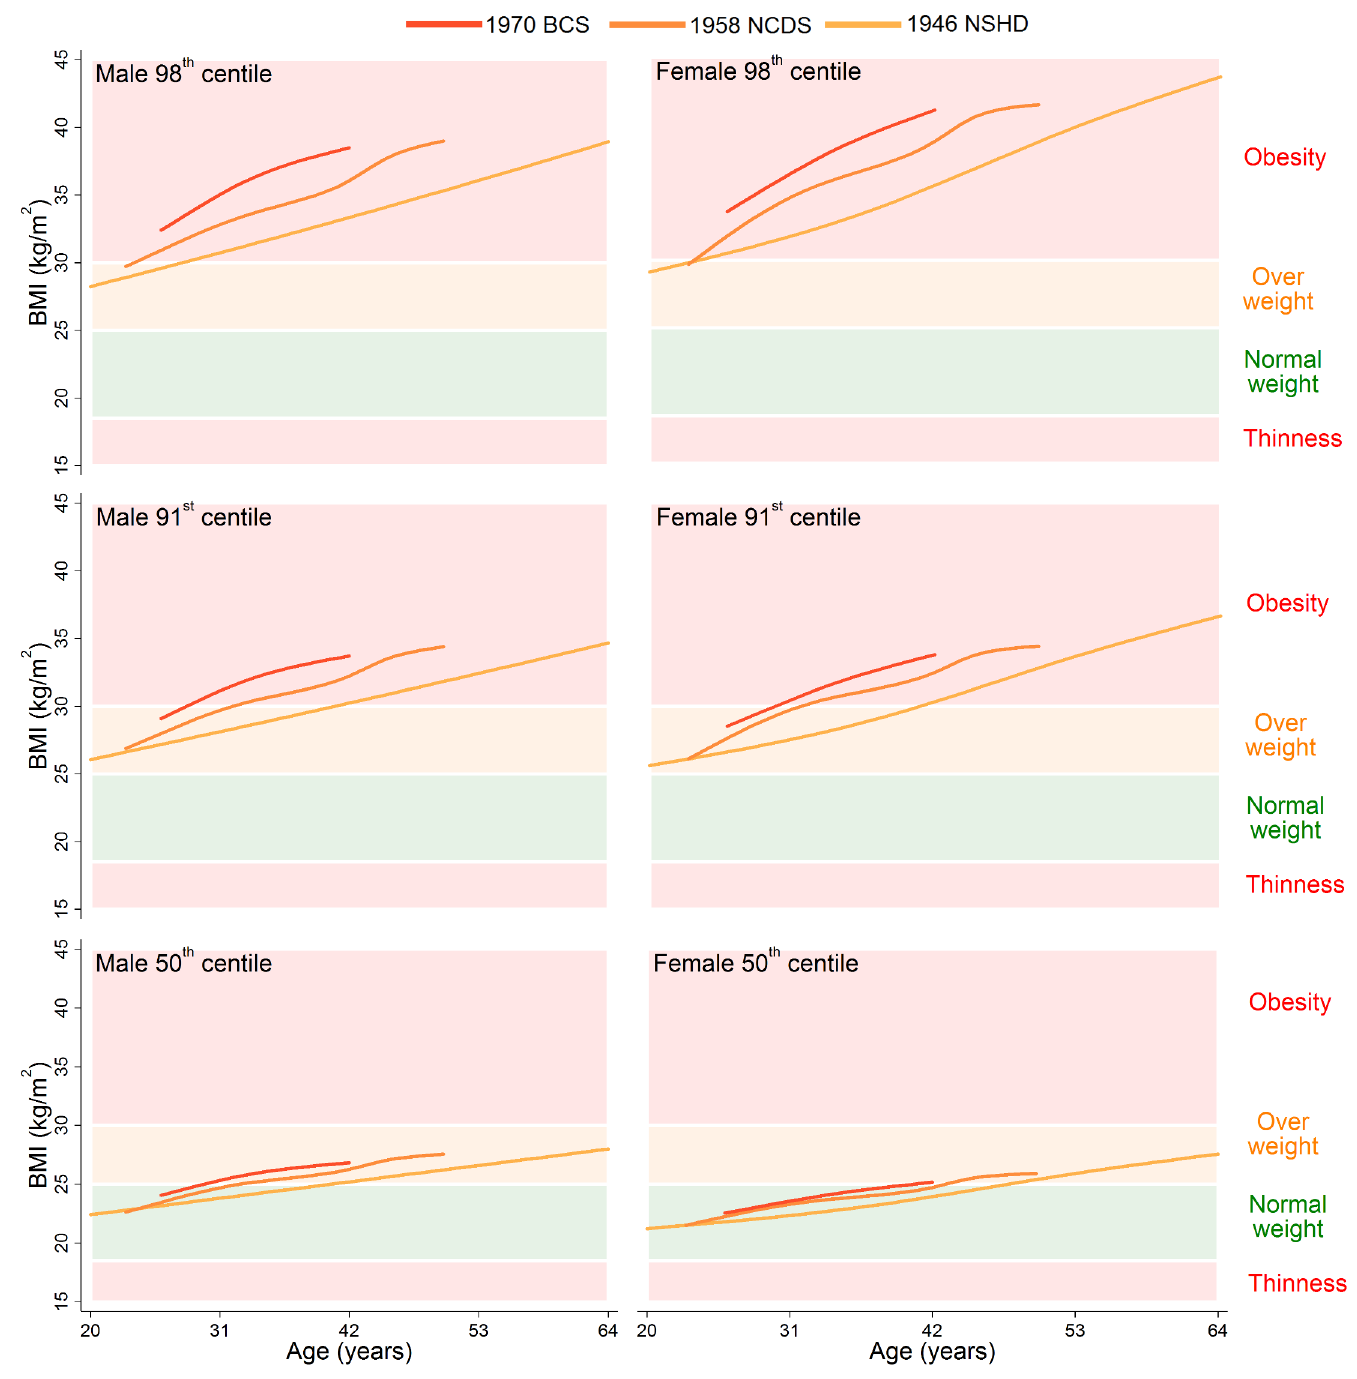
Fig 2. The 98 th , 91 st , and 50 th adulthood BMI centiles from sex- and study-stratified LMS models plotted against the normal cut-offs. BMI: Body Mass Index, LMS: Lambda-Mu-Sigma, NSHD: Medical Research Council National Survey of Health and Development, NCDS National Child Development Study, BCS: British Cohort